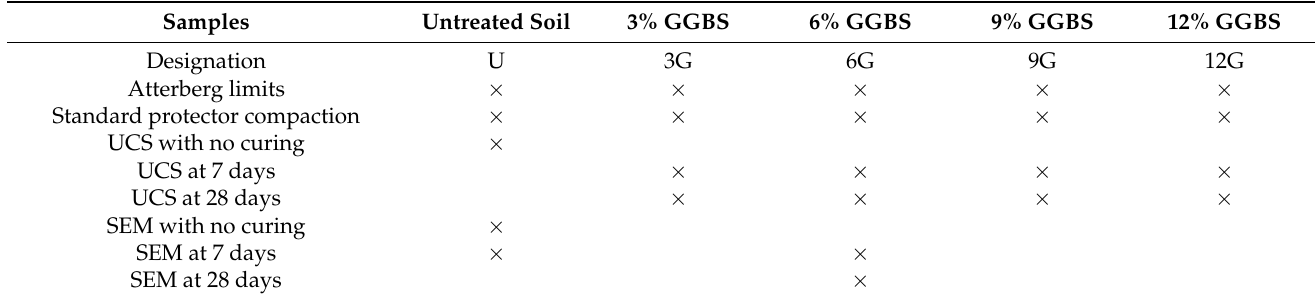
Table 4. Summary of the test program and performed test for the first stage.